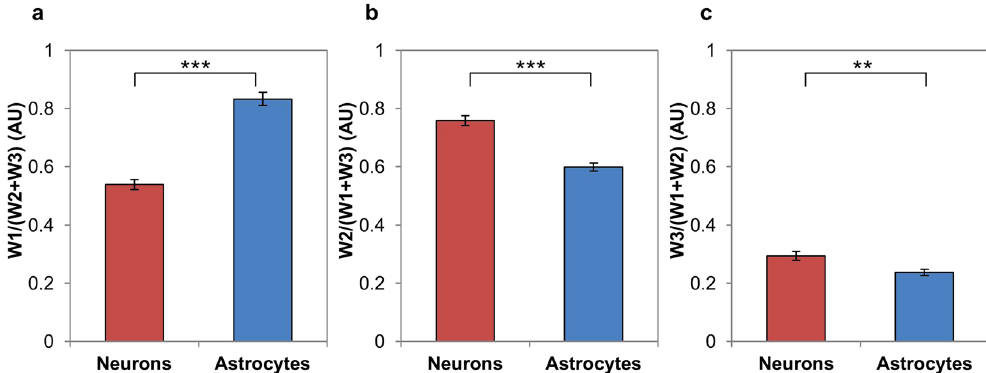
Figure 4. Quantitative comparisons of redox ratio component relative weights. ( a ) Astrocytes have significantly greater relative weight on redox ratio distribution component 1 than neurons. ( b ) Neurons have significantly greater relative weight on redox ratio distribution component 2 than astrocytes. ( c ) Neurons have significantly greater relative weight on redox ratio distribution component 3 than astrocytes. ** p < 0.01, *** p <